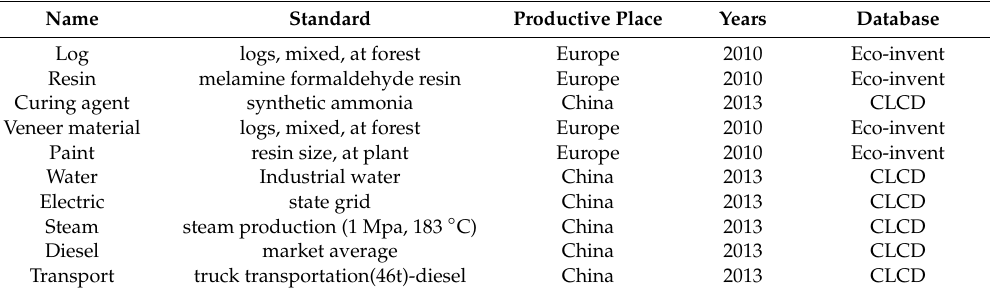
Table 1. Upstream data of plywood products.